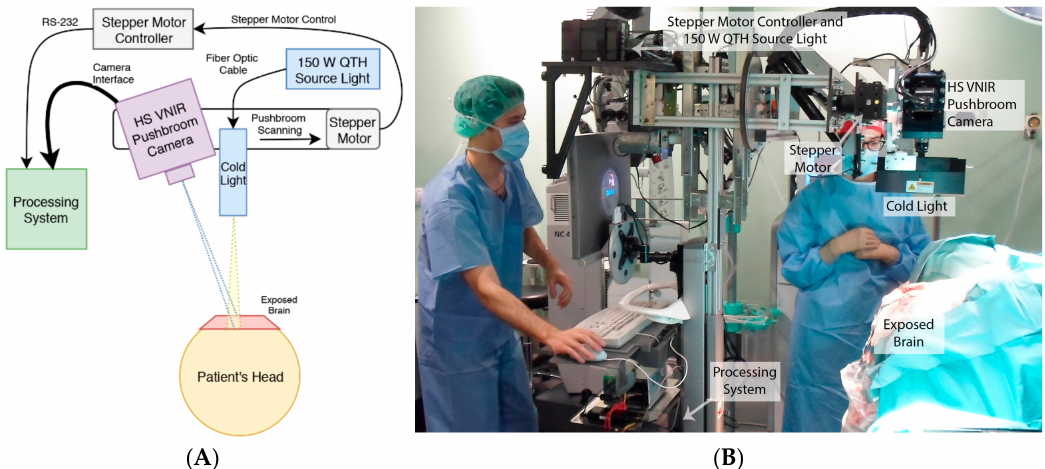
Figure 1. Hyperspectral acquisition system. ( A ) Schematic diagram of the HS acquisition system; ( B ) HS acquisition system capturing an image during a neurosurgical operation at the University Hospital Doctor Negrin of Las Palmas de Gran